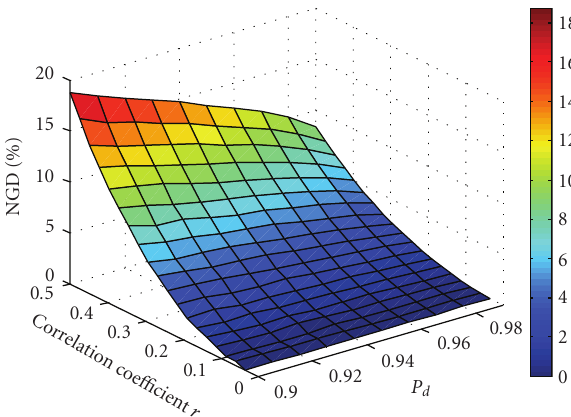
Figure 4: Values of correlation coe ffi cient where the performance of EG combiner becomes worse than static antenna for a range of target detection performance metrics.